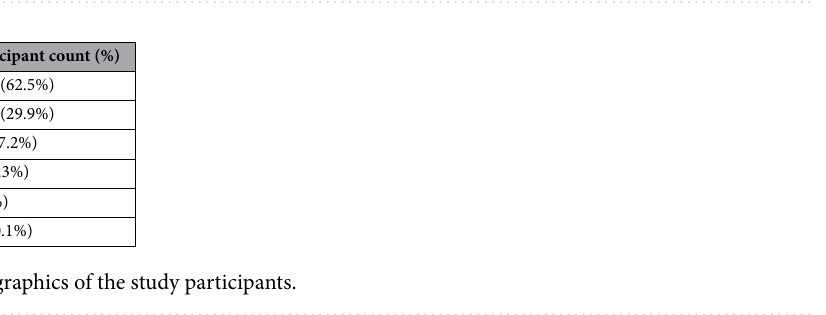
Figure 5. ( a ) Illustration of sliding window-based feature extraction. ( b ) Example of true positive and true negative classification under multiple instance learning training objective. ( c ) Illustration of learned feature risk scores (black curves) along with population distribution underlays for Sick (red) and Control (blue) populations included in the infection prediction mode.